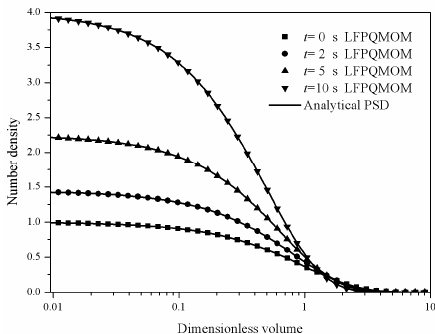
Figure 16. Particle size distribution at 0, 2, 5, and 10 s for the pure breakage process with linear kernel, exponential initial PSD, and uniform daughter distribution (square: numerical PSD at 0 s; circle: numerical PSD at 2 s; up triangle: numerical PSD at 5 s; down triangle: numerical PSD at 10 s; line: analytical PSD). Processes 2018 , 6 , x FOR PEER REVIEW